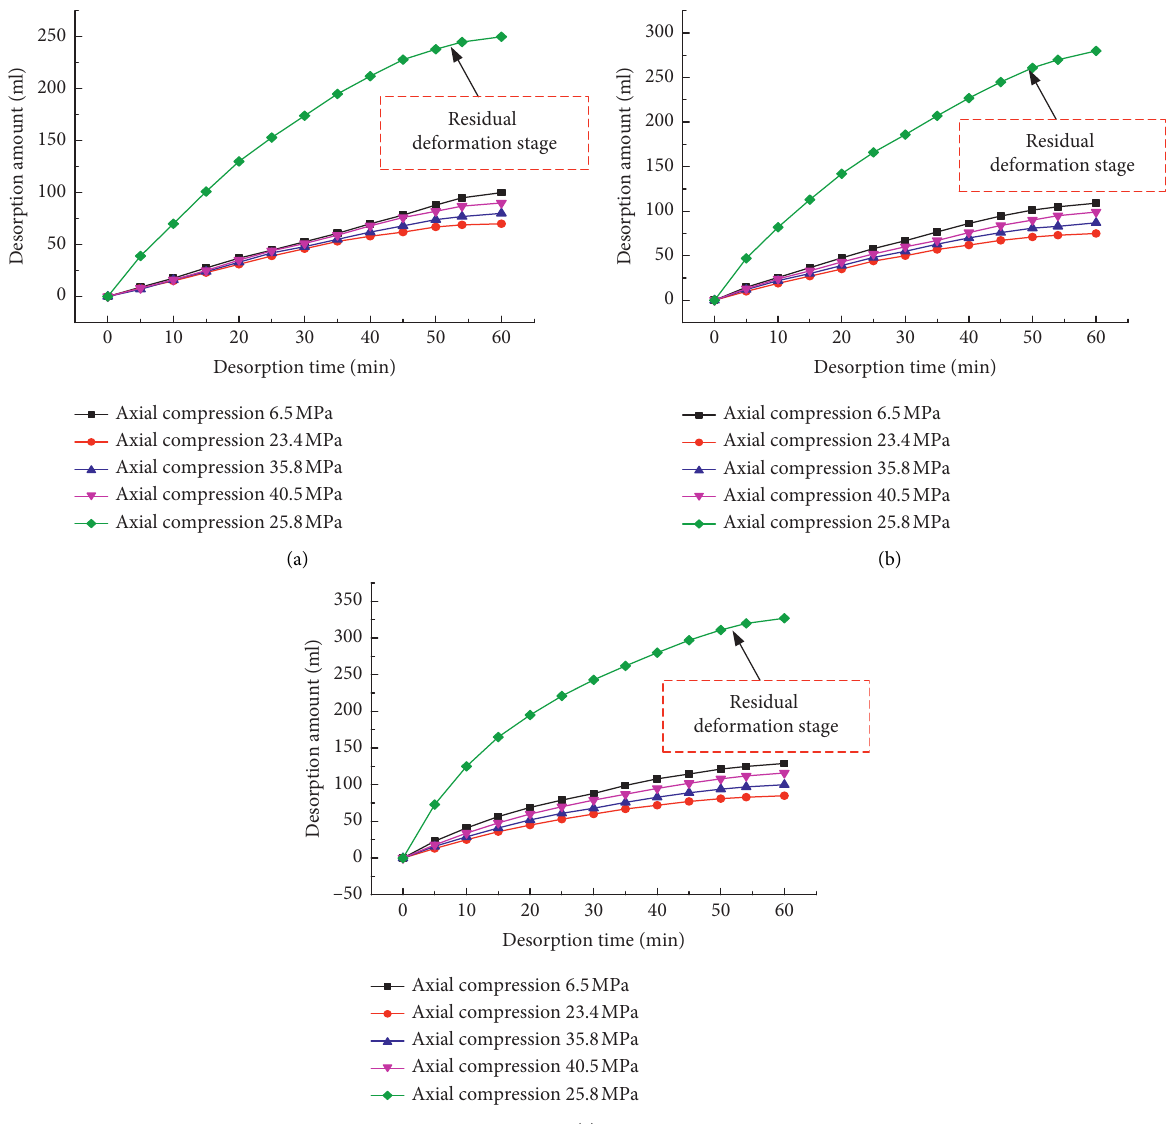
Figure 9: Desorption amount curve under the confining pressure of 3MPa at the temperature of (a) 30 ° C, (b) 45 ° C, and (c) 60 °